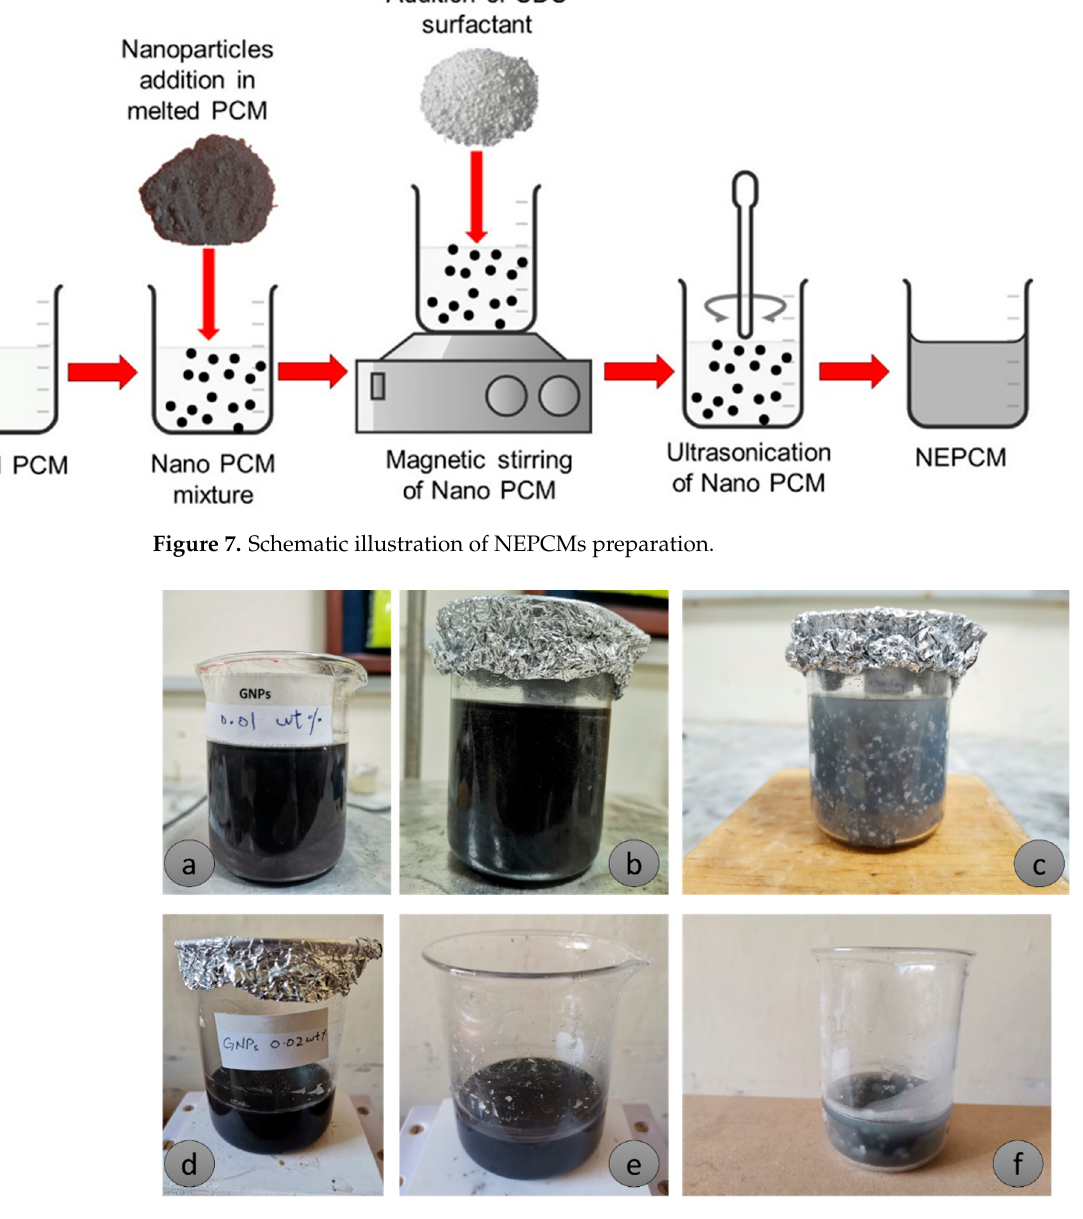
Figure 8. GNPs samples: [0.01 wt. % ( a ) after preparation; ( b ) after 30 min; ( c ) in solid form]; [0.02 wt. % ( d ) after preparation; ( e ) after 30 min; ( f ) in solid form].